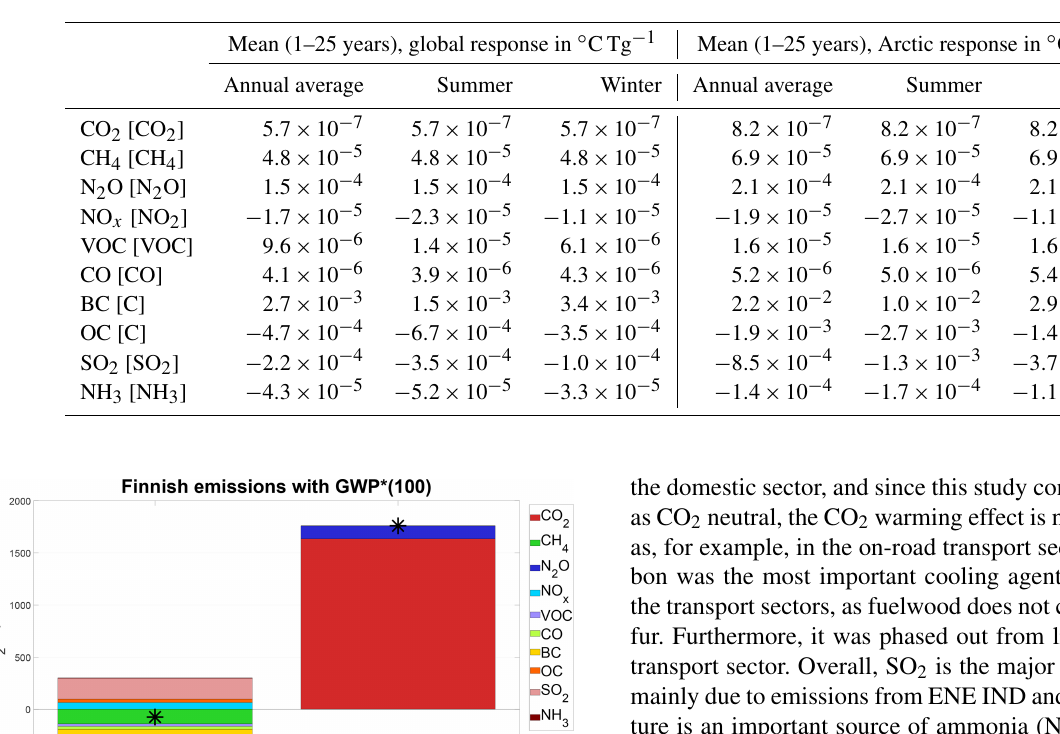
Table 3. The climate metric values ( ◦ CTg − 1 ) used in this study. Mean ARTP (1–25 years) values for SLCF and GHG emissions. The Arctic response for the GHGs is based on the latitudinal pattern for CH 4 . The annual average is based on emissions in 2010. Normalized values (CO 2 equivalents) are shown in Table S2.